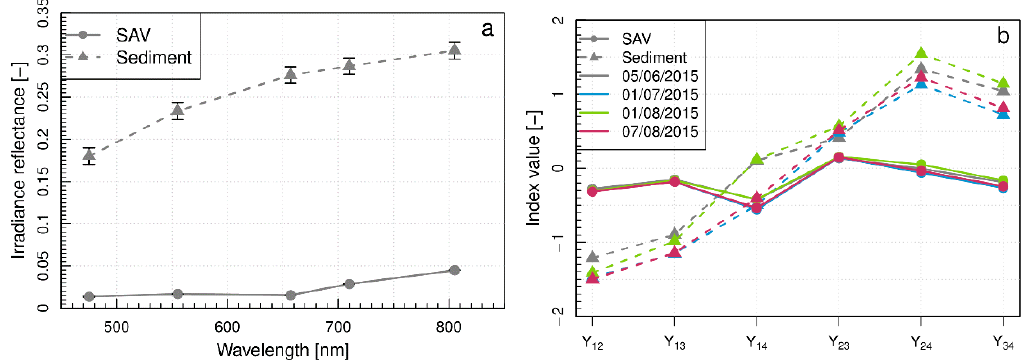
Figure 3. ( a ) Irradiance reflectance of submerse aquatic vegetation (SAV) and bare sediment, measured ex situ and resampled to RapidEye. Error bars indicate standard deviation; ( b ) Depth-invariant indices for sediment and SAV for the different days, calculated according to the equation of Lyzenga [35] (Equation (5)).